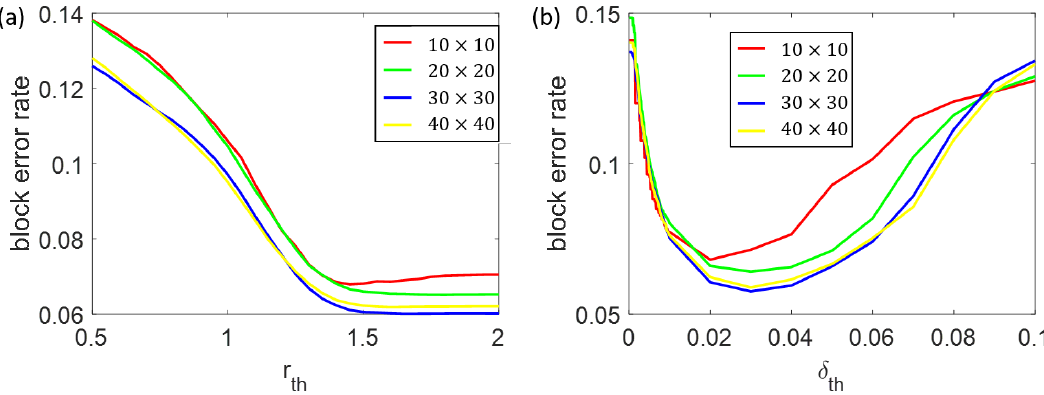
Figure 5. Block error rate of the joint diagnosis algorithm under different array scales: ( a ) with the scan of r th ; and ( b ) with the scan of δ th